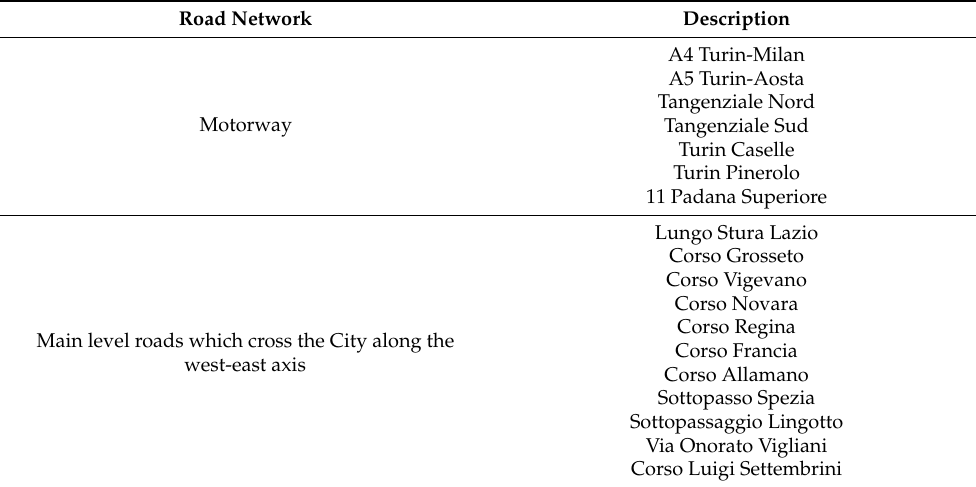
Figure 6. Road infrastructure system. Authors’ elaboration based on data provided by the City of Turin [29]. Table 4. Road system. Authors’ elaboration based on data provided by the City of Turin [29] .